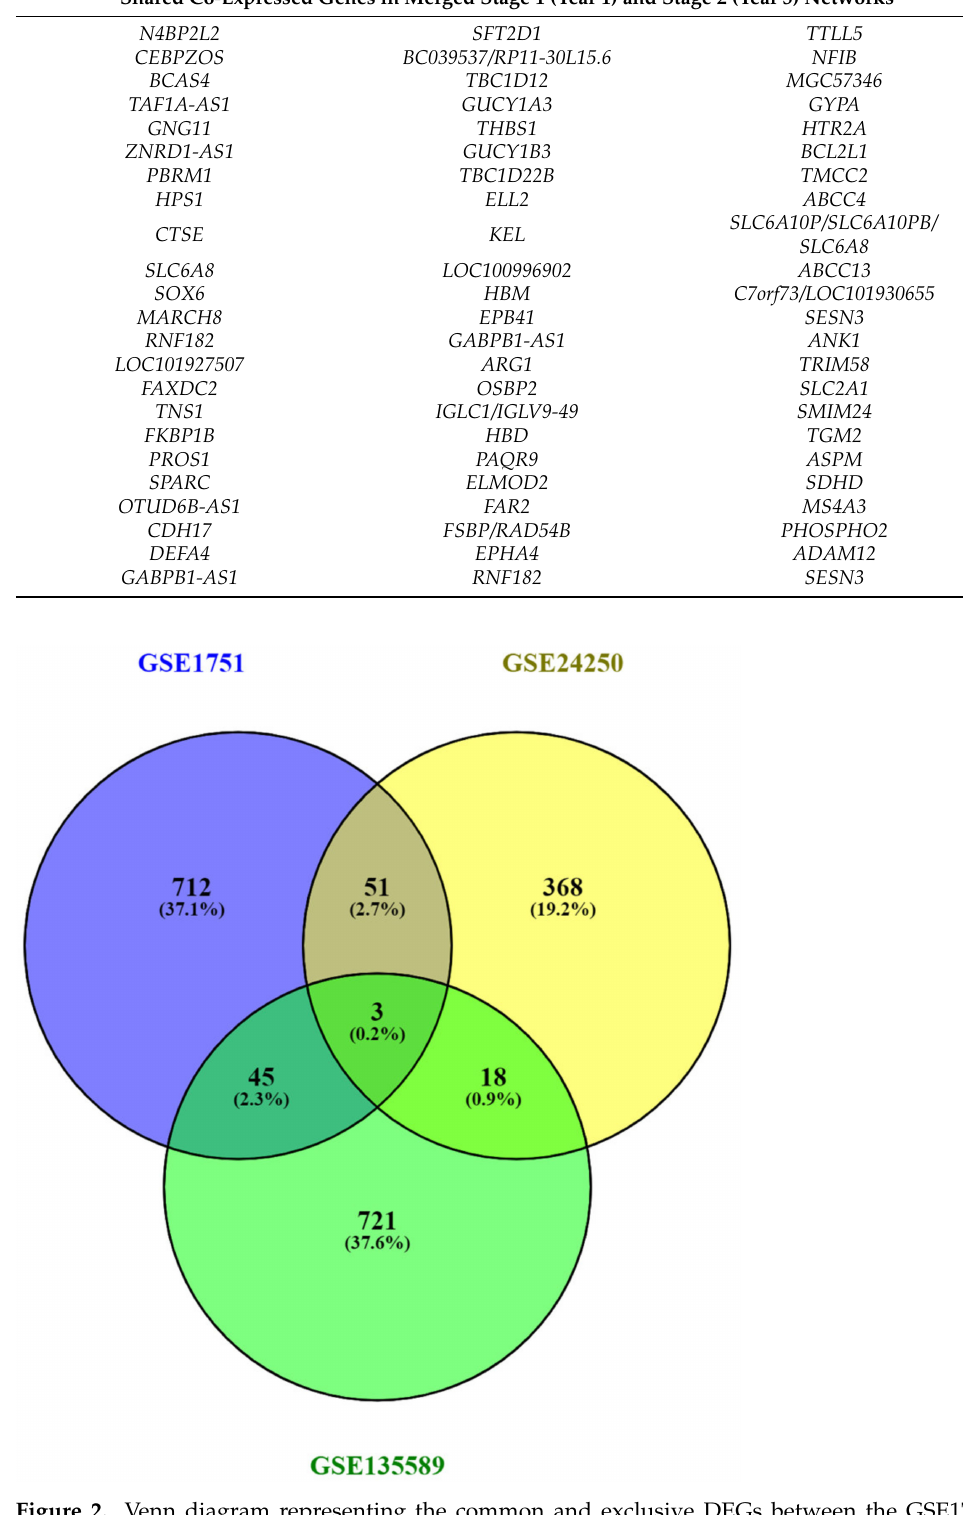
Figure 2. Venn diagram representing the common and exclusive DEGs between the GSE1751, GSE24250 and GSE135589